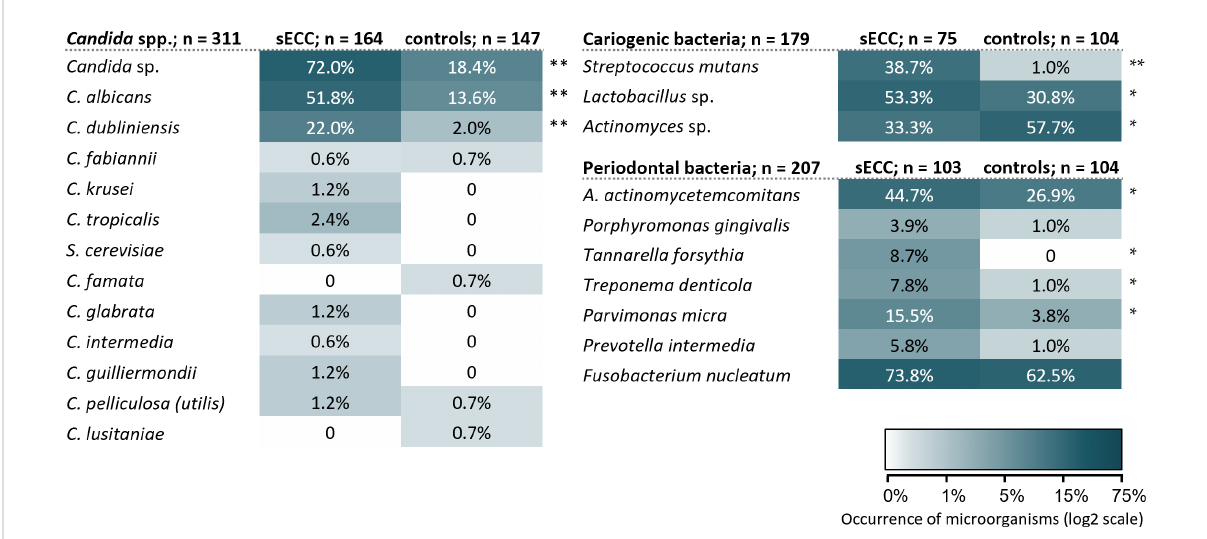
FIGURE 2 Occurrence and diversity of the investigated oral microorganisms in the subgingival and supragingival dental plaque in the groups of children with sECC and controls. A. actinomycetemcomitans , Aggregatibacter actinomycetemcomitans ; C. , Candida ; S. cerevisiae , Saccharomyces cerevisiae. */** p < 0.05/ p < 0.001, statistically signi fi cant results between group of the children with sECC and controls, the difference is tested with Fisher ’ s exact